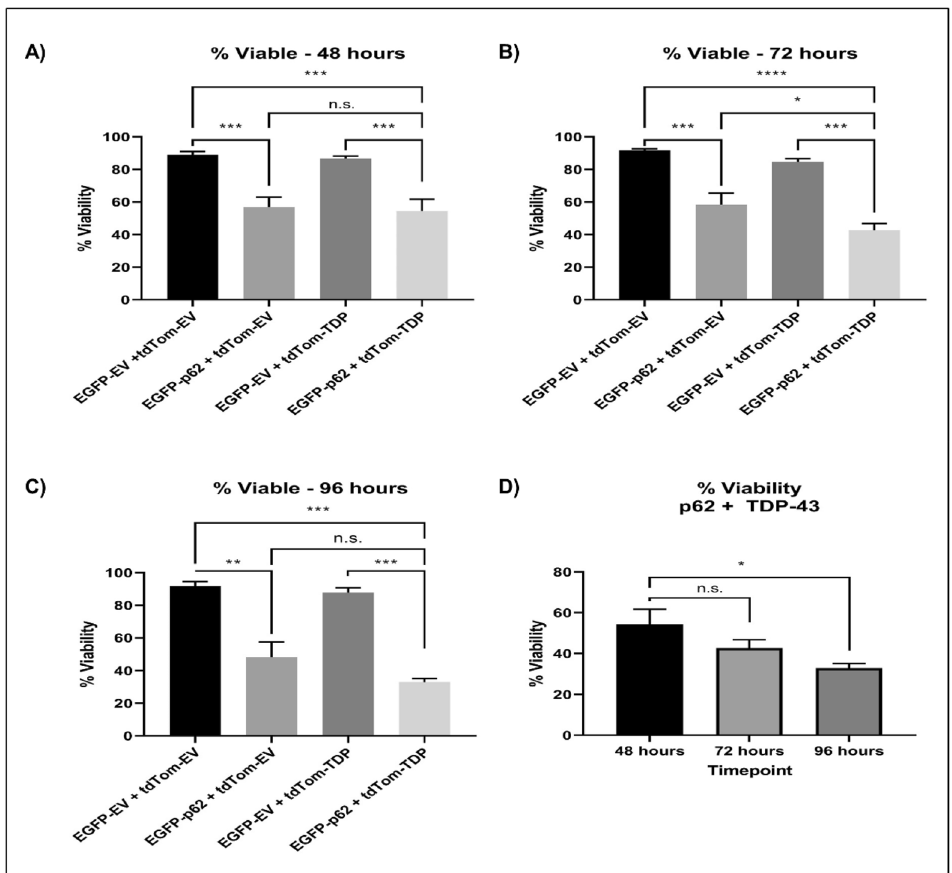
Figure 8. Expression of p62 causes neuronal death. Cells were transfected with EGFP empty vector (EGFP-EV) and RFP empty vector (RFP-EV), EGFP-p62 with or without TDP-43-tdTomato (RFP-TDP) or TDP-43- tdTomato with EGFP-EV. At ( A ) 48, ( B ) 72 or ( C ) 96 h post-transfection cells were trypsinised and incubated with Sytox-Red and assessed for cell viability by flow cytometry, ( D ) percentage viability of cells expressing